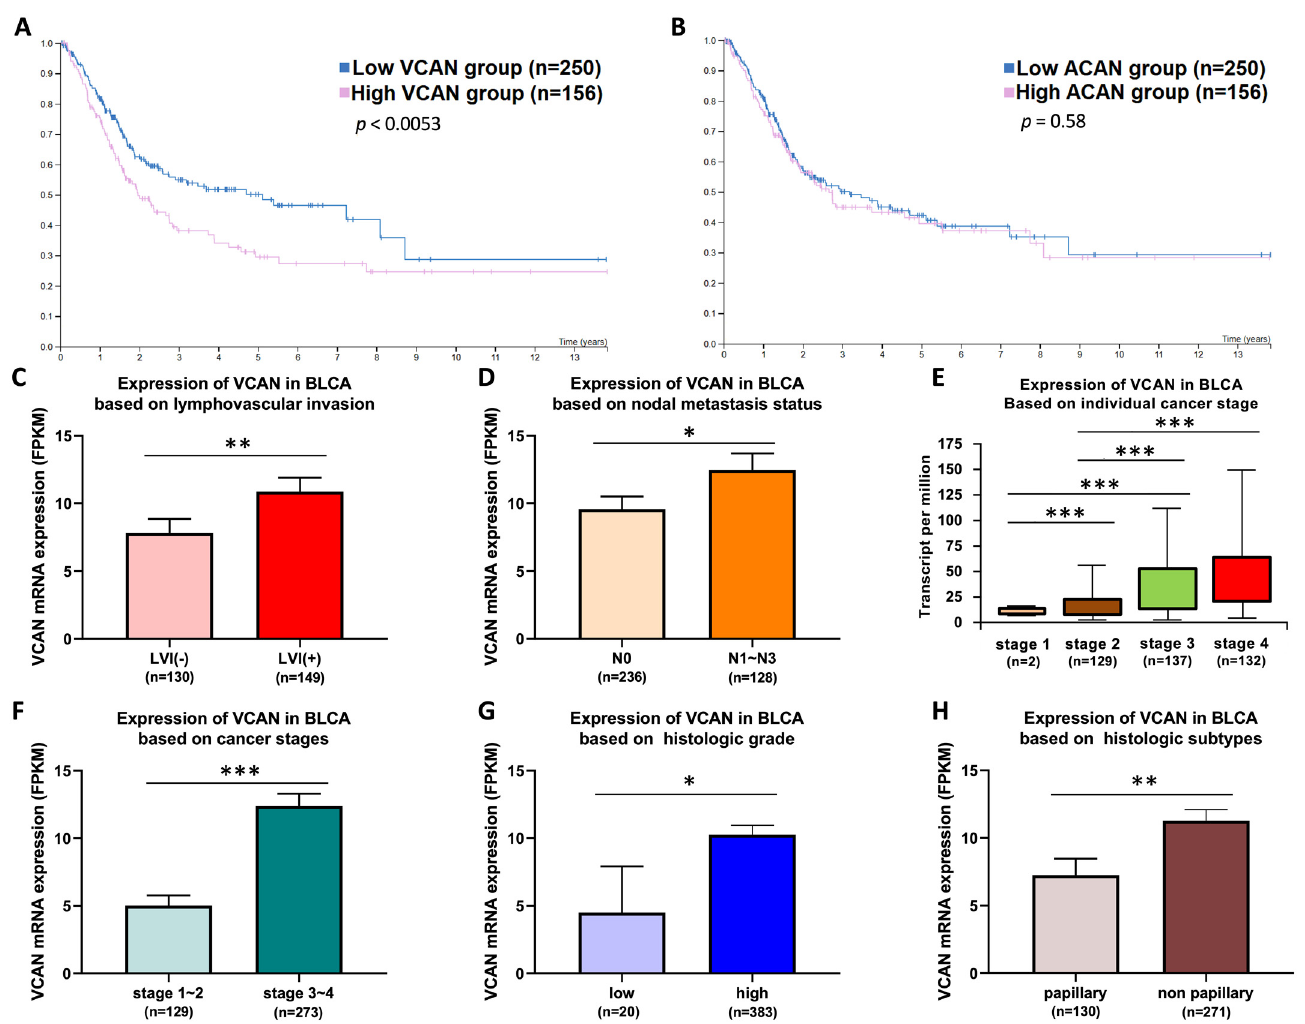
Figure 2. Positive correlation between VCAN expression and poor prognosis, advanced tumor stage, lymph node metastasis and histologic subtypes of UTUC. ( A , B ) Survival analysis of patients with high or low expression of VCAN or ACAN in the BLCA database (n = 406) using a log-rank test (log-rank test, p < 0.01 and 0.58, respectively). ( C ) High expression of VCAN was significantly associated with lymphovascular invasion in BLCA ( p < 0.01). ( D ) High expression of VCAN was significantly associated with metastatic lymph nodes ( p < 0.05). ( E , F ) High expression of VCAN was significantly associated with advanced stages of BLCA (all, p < 0.001). ( G ) High expression of VCAN was significantly associated with high-grade BLCA ( p = 0.05). ( H ) High expression of VCAN was significantly associated with non-papillary subtypes of UTUC ( p < 0.01). All statistics were determined using a two-tailed Student’s t -test. * p < 0.05; ** p < 0.01; *** p <